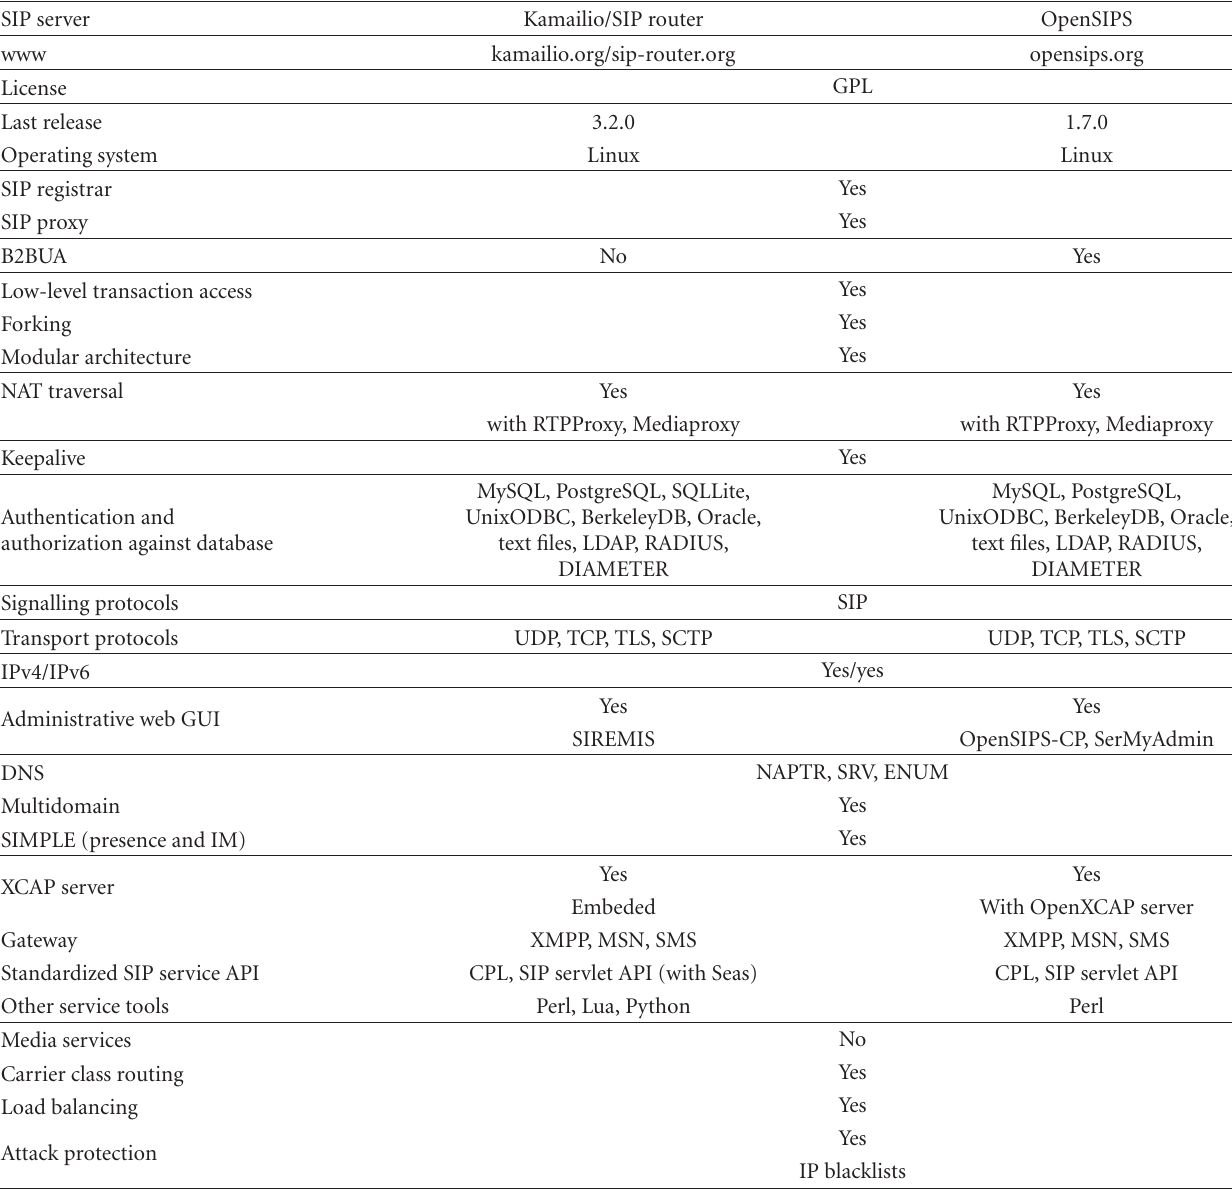
Table 2: SIP PROXY server